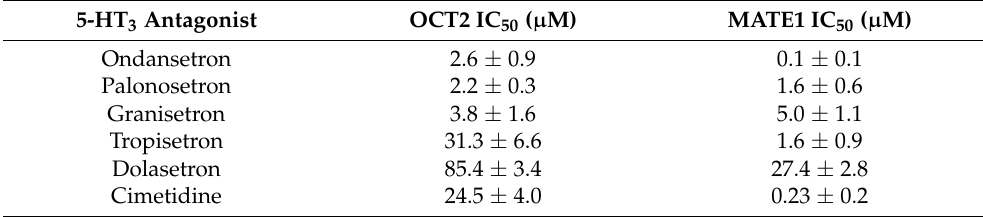
Table 1. 5-HT 3 antagonist inhibition of in vitro ASP + transport by OCT2 and MATE1 in HEK293 cells 1